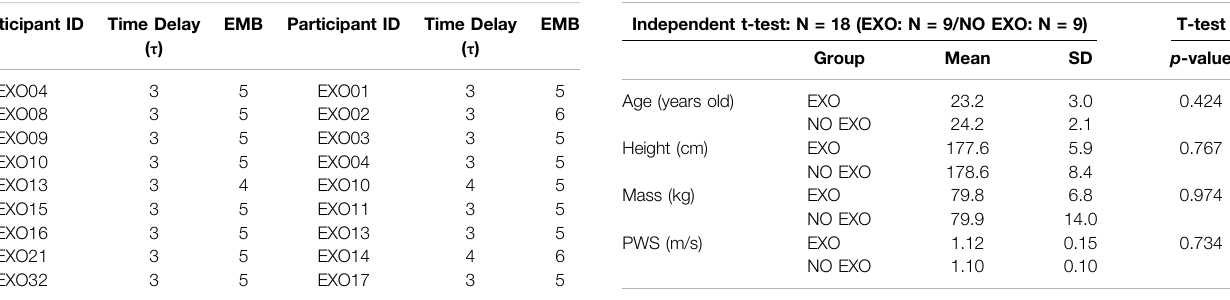
TABLE 1 | Time delay and the EMB values for each participant in the EXO and the NO EXO groups. These values were used to reconstruct state space fi gures and perform cRQA.